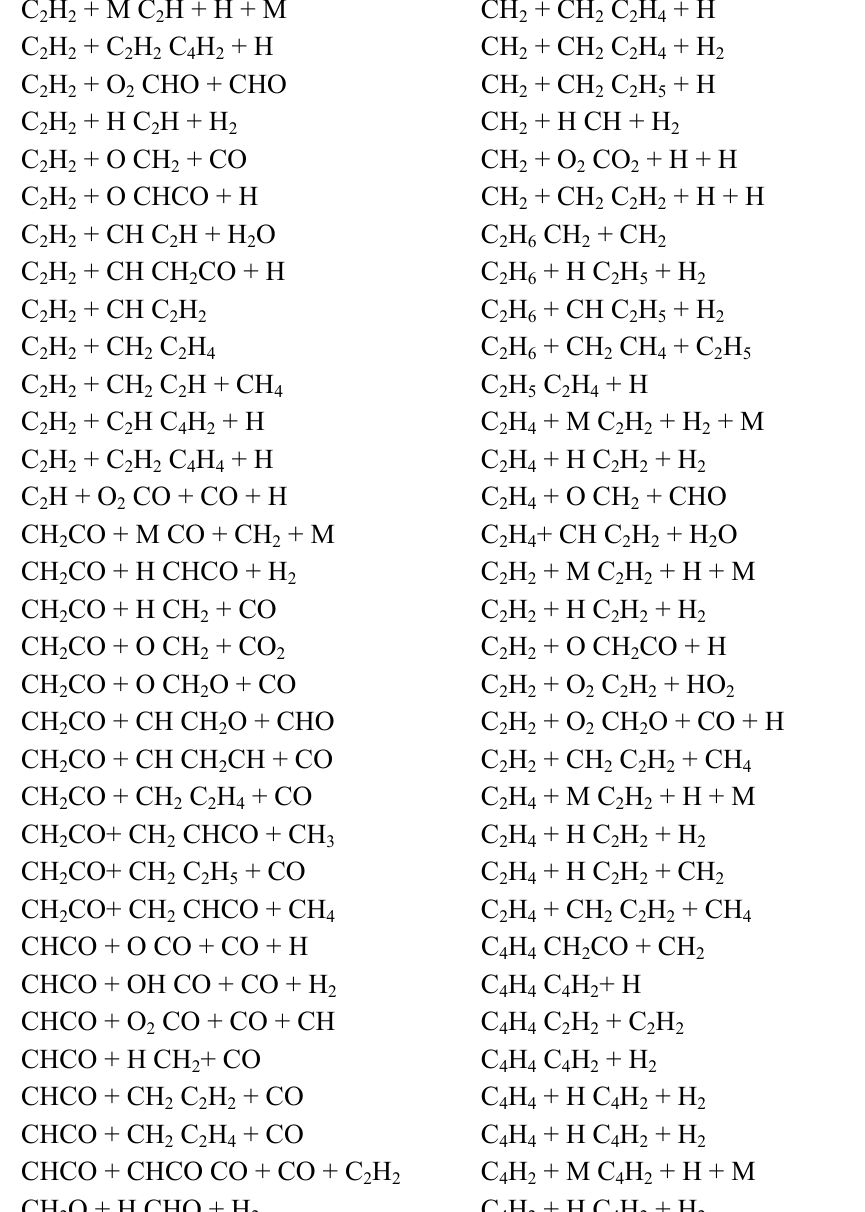
Table 11. Acetylene combustion mechanisms proposed by Hidaka et al .